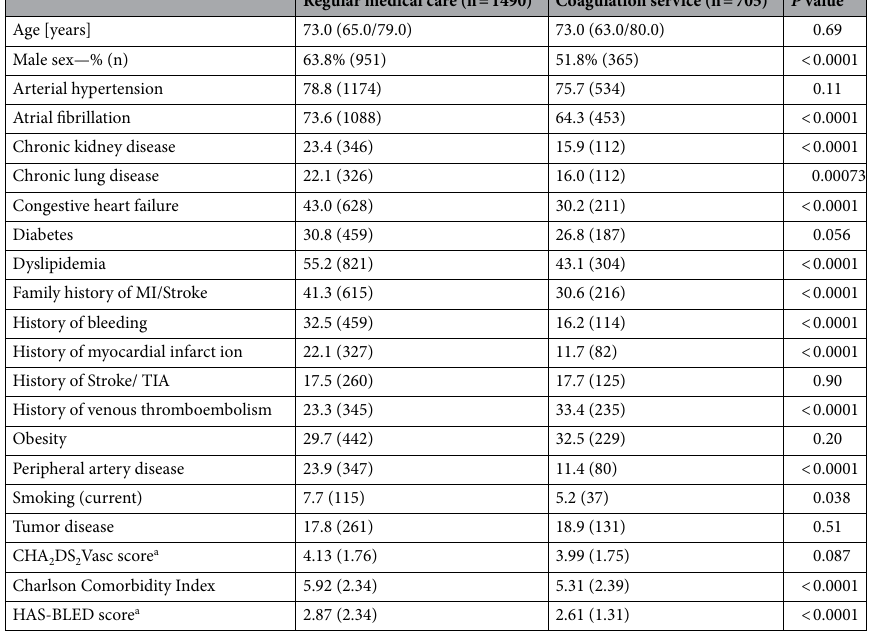
Table 1. Baseline characteristics of study participants according to healthcare model. Data are expressed as the relative and absolute frequency for binary variables; all information is displayed for baseline frequency. a Calculated for patients with atrial fibrillation